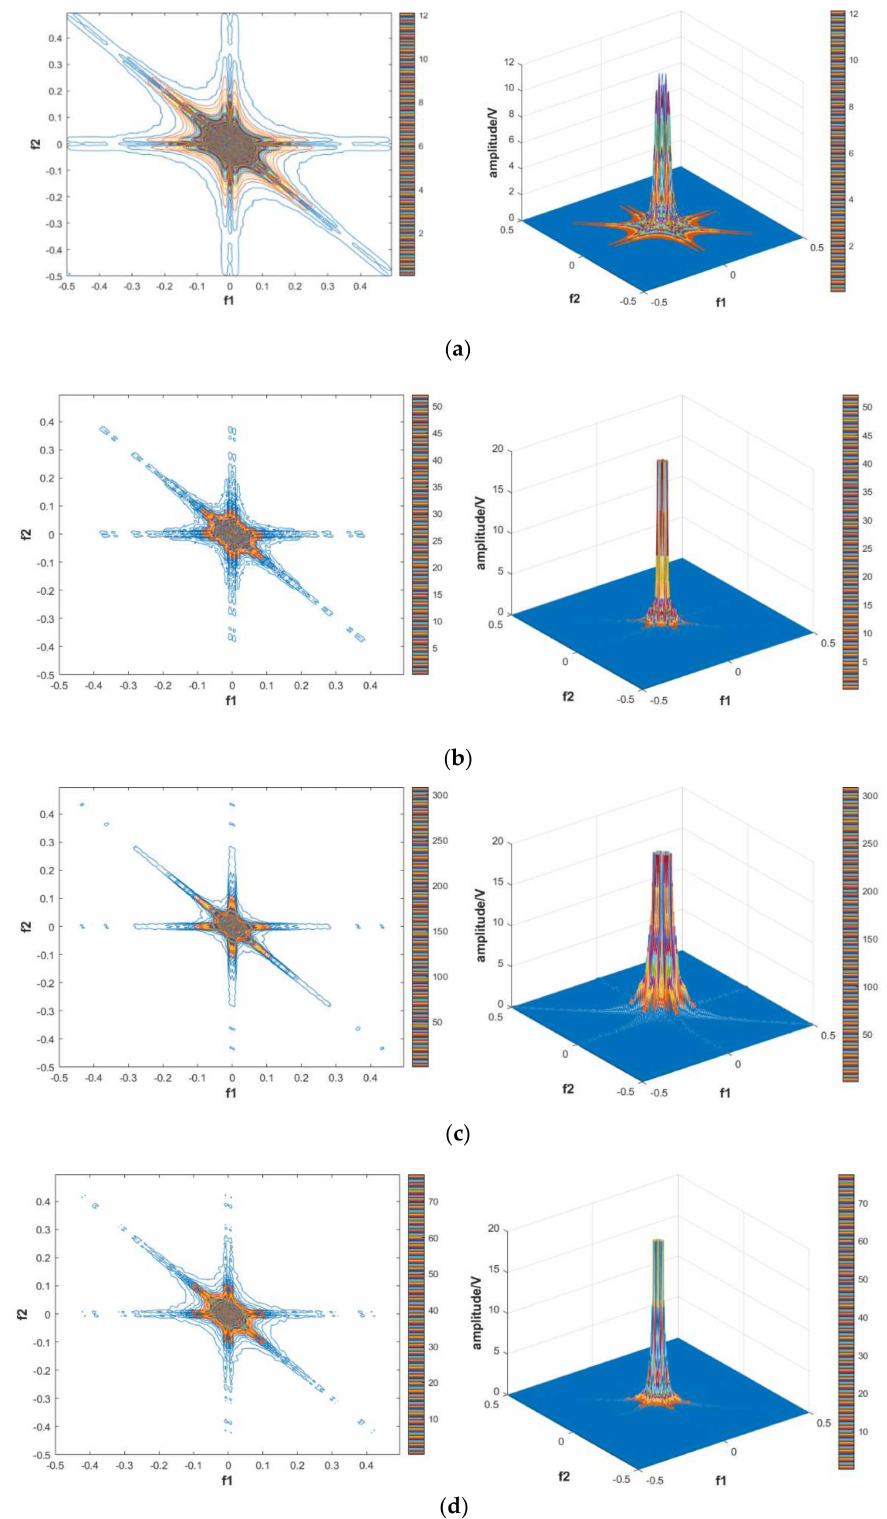
Figure 3. Contour plot of three order spectrum and 3D plot for fuze output signals under the action of target and jamming. ( a ) Contour plot of three order spectrum and 3D plot for the target signal; ( b ) Contour plot of three order spectrum and 3D plot for noise AM frequency sweep signal; ( c ) Contour plot of three order spectrum and 3D plot for sine AM frequency sweep signal; ( d ) Contour plot of three order spectrum and 3D plot for square AM frequency sweep